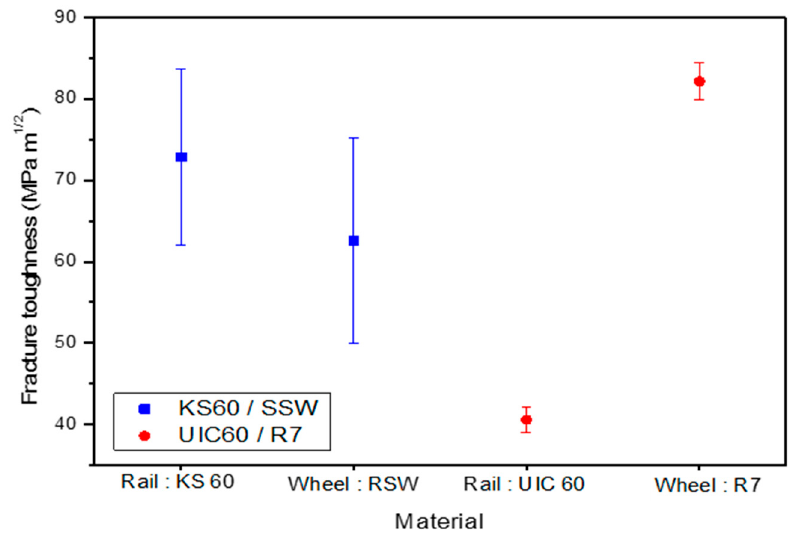
Figure 12. Comparison of fracture toughness by wheel and rail steel.